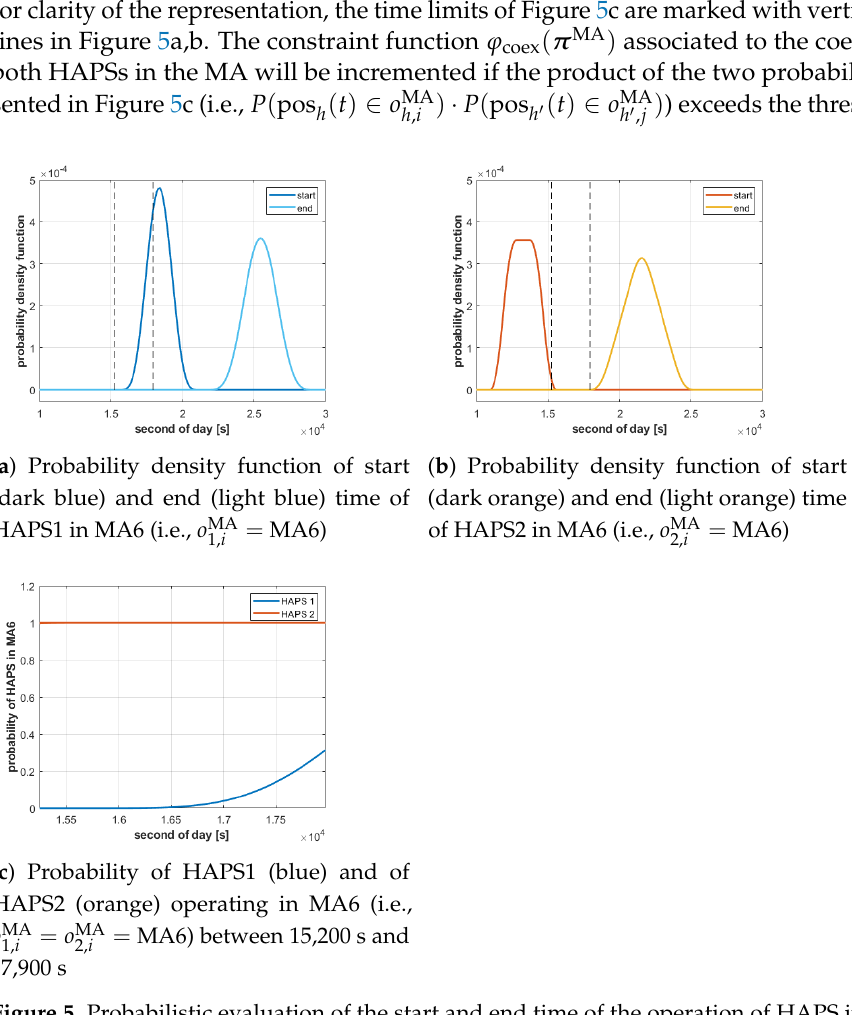
Figure 5. Probabilistic evaluation of the start and end time of the operation of HAPS in a MA and probability of their operation in the MA within the duration marked by the vertical dash